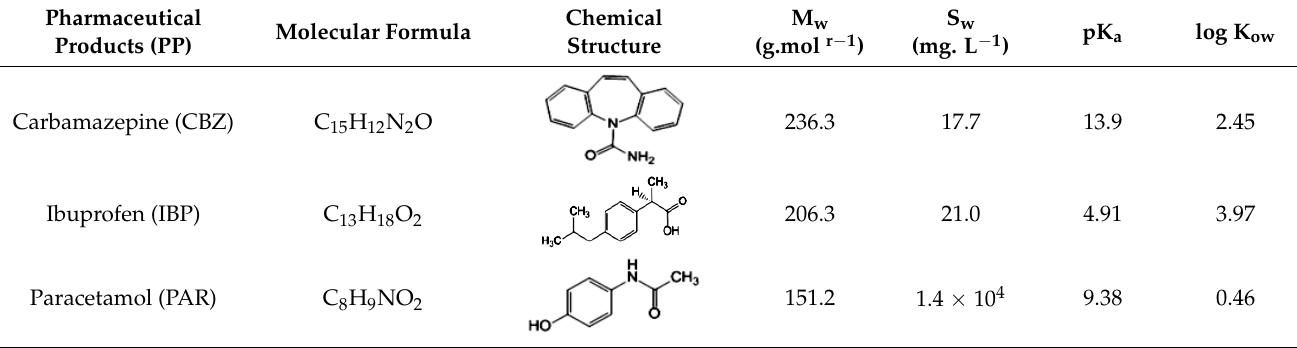
Table 3. Physico-chemical properties of the pharmaceutical preparations studied (M w – molecular weight, S w – solubility in water, pK a – the negative log of the acid dissociation constant, log K ow – the octanol/water partition coefficient).